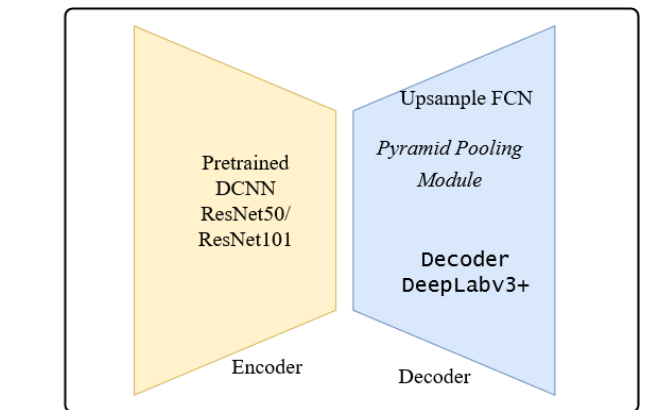
Figure 7. Encoder-Decoder Architecture: 2 variants of encoder architectures and 3 types of decoder architecture, in total 6 CNN